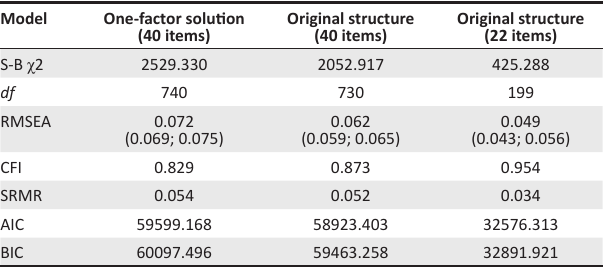
TABLE 3: Phi coefficient matrix (Sample 2, n = 308).